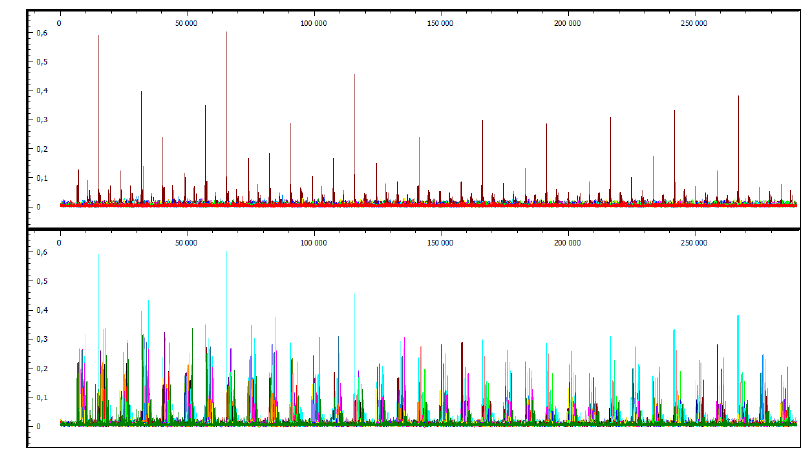
Figure 10: Monobit SNRs (on 50 , 000 traces) for the first operand of the MMM . Top: 32 SNR traces for each bit of the least significant 32-bit word. Bottom: 34 SNR traces for all the 12th bit of each 32-bit sub-word of the